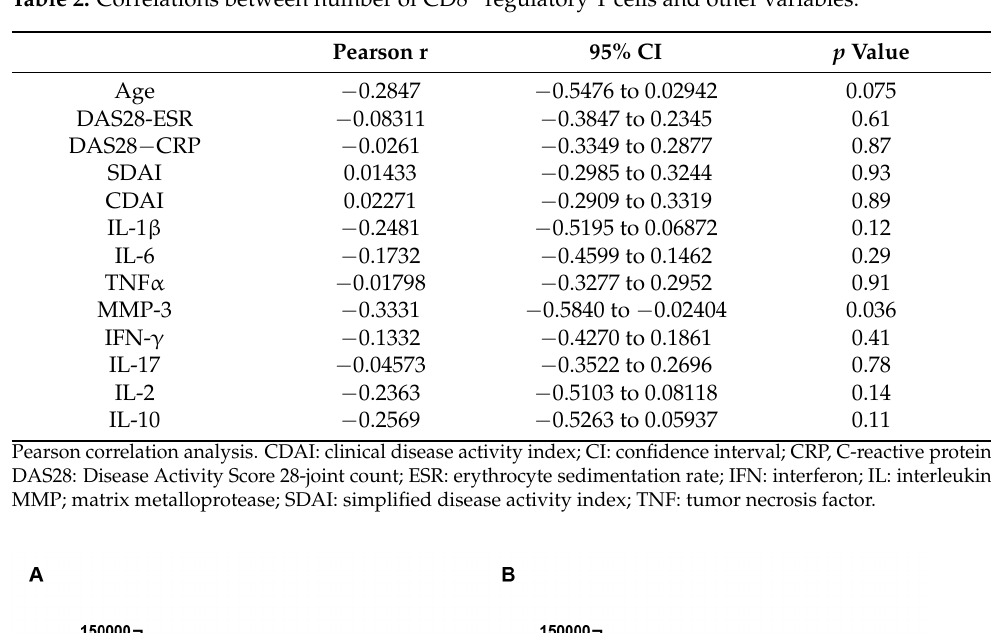
Table 2. Correlations between number of CD8 + regulatory T cells and other variables.